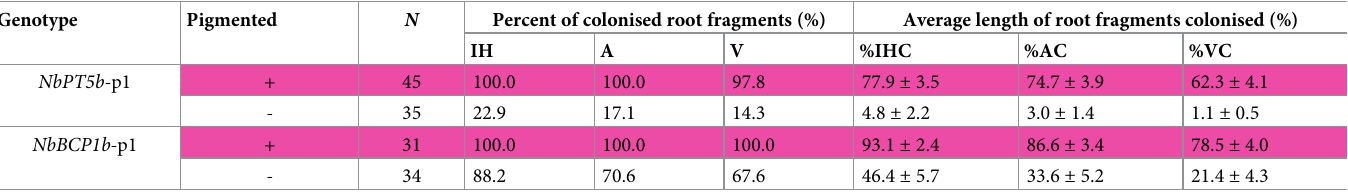
Table 1. Quantification of fungal structures observed in roots of Nicotiana benthamiana expressing NbPT5b -p1 and NbBCP1 -p1 4 wpi with Rhizophagus irregularis .